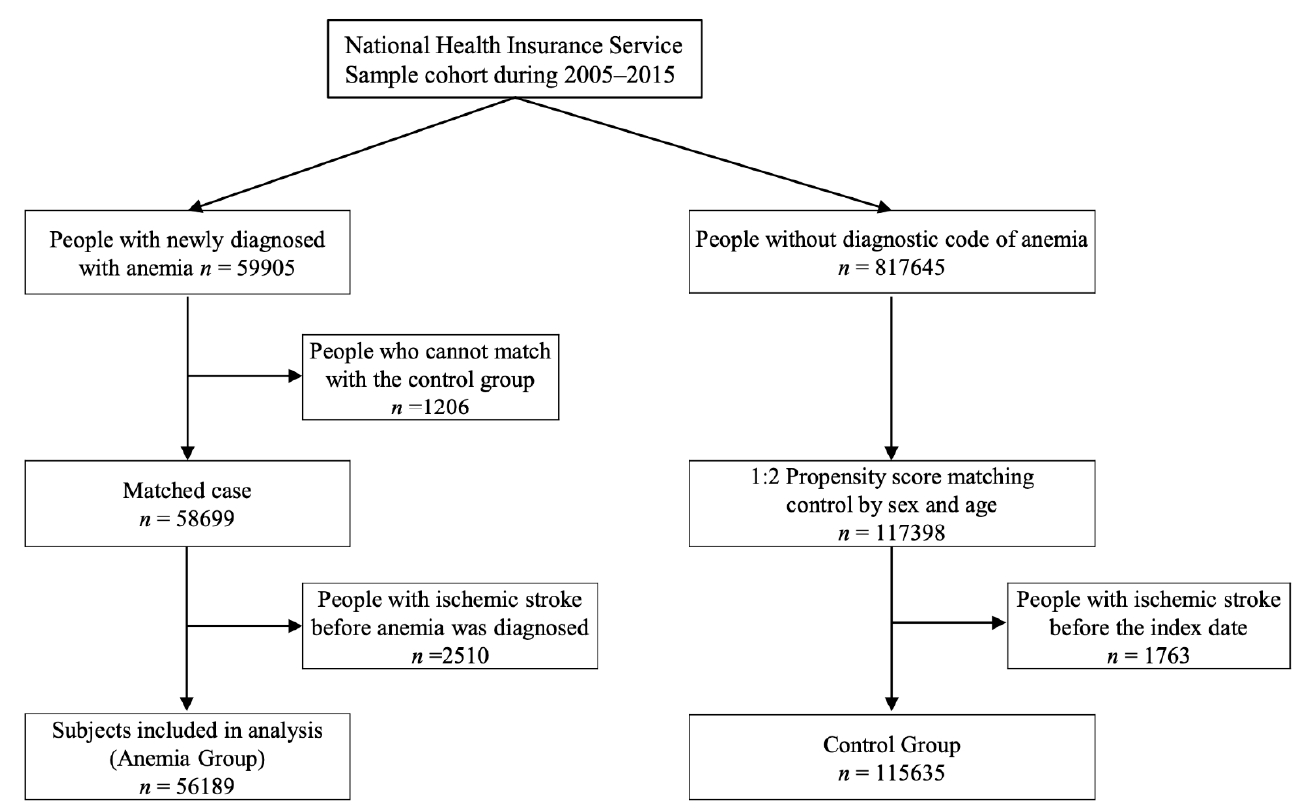
Figure 1. The flowchart of the study patients. Table 1. Demographic characteristics of subjects with anemia and without anemia extracted from sample cohort.